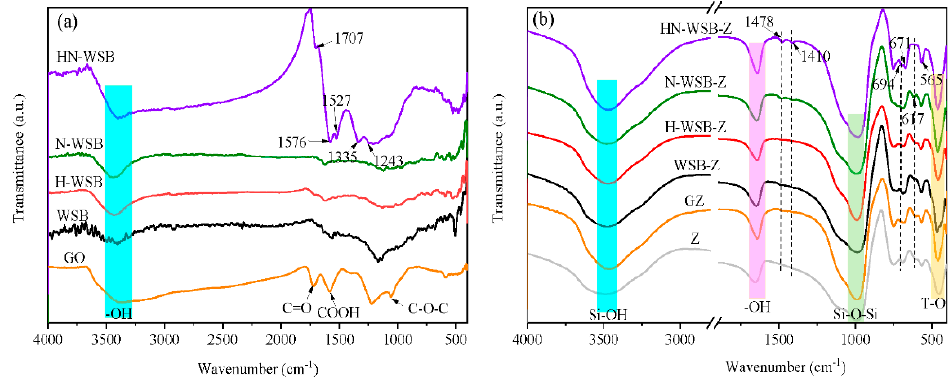
Figure 4. FTIR spectra of GO and different biochars ( a ); GO composite FAU, different biochar composite FAUs and pure FAU ( b ).